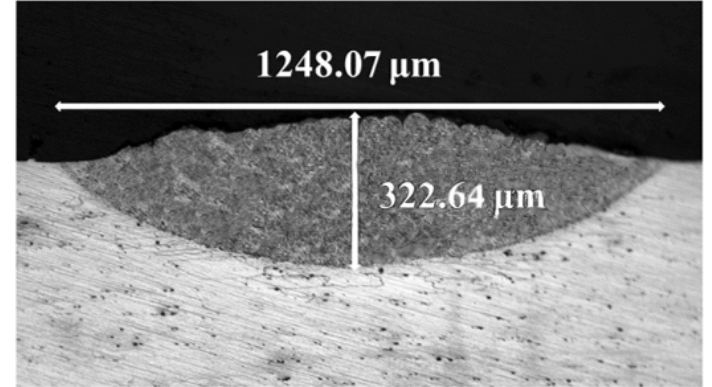
Figure 6. The macroscopic cross-sections of the